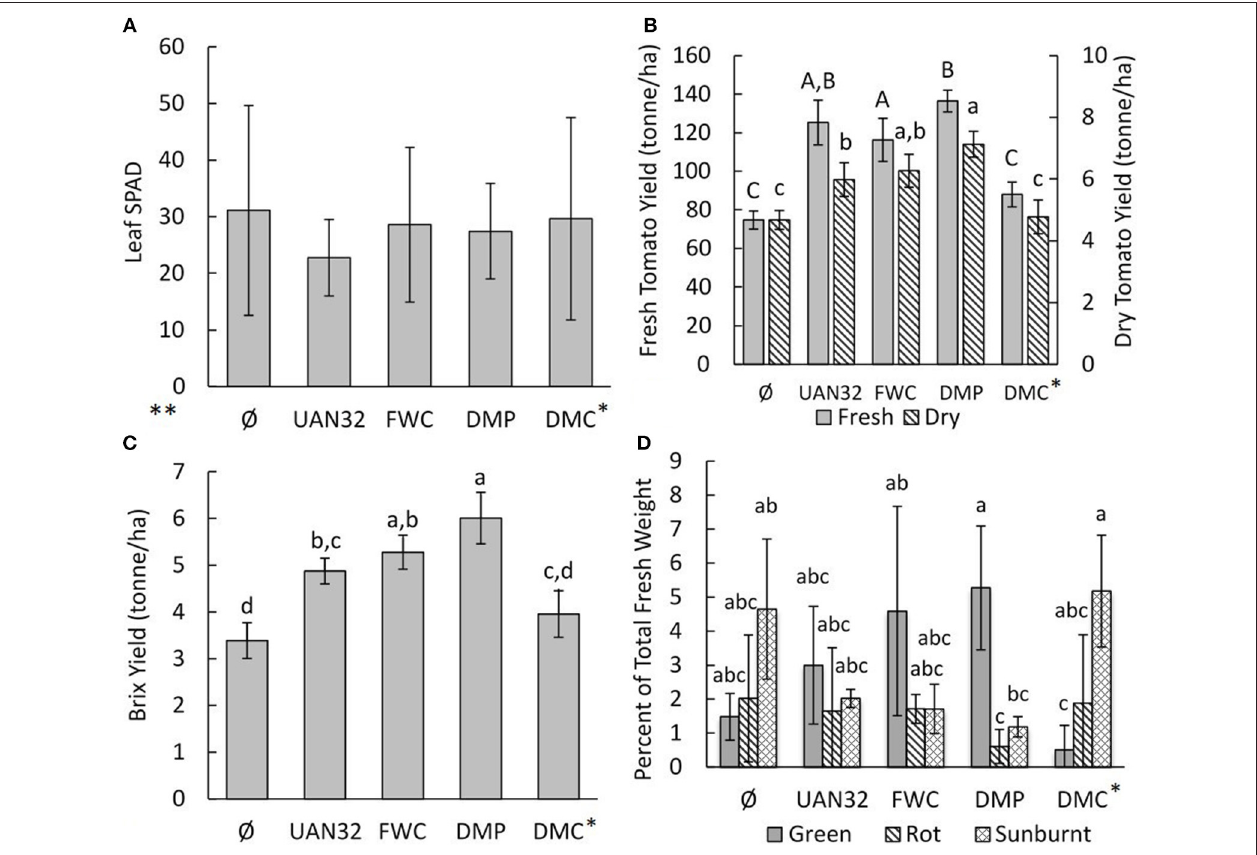
FIGURE 3 | (A**) Chlorophyll SPAD measurements of the tomato plants treated with different fertilizers ( n = 26, N = 104), (B) Fresh and dry red tomato yield ( N = 4), (C) Brix yield of red tomato ( N = 4), and (D) Percentage of total fruit obtained that had undesirable qualities (green, rot, sunburn) ( N = 4). Letter categories represent significance at the α = 0.05 level. *Note that the DMC treatment was abandoned after the first fertigation event due to difficulties in applying it due to excessive particle flocculation. **Statistical analysis of leaf SPAD data is not presented as the data was highly non-normal and heteroscedastic.